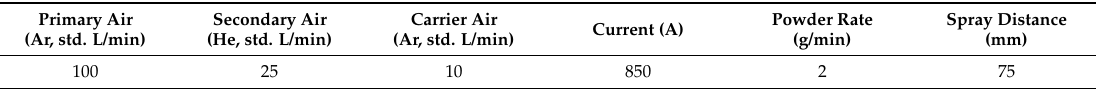
Table 1. Parameters of APS processing for NiCr 2 O 4